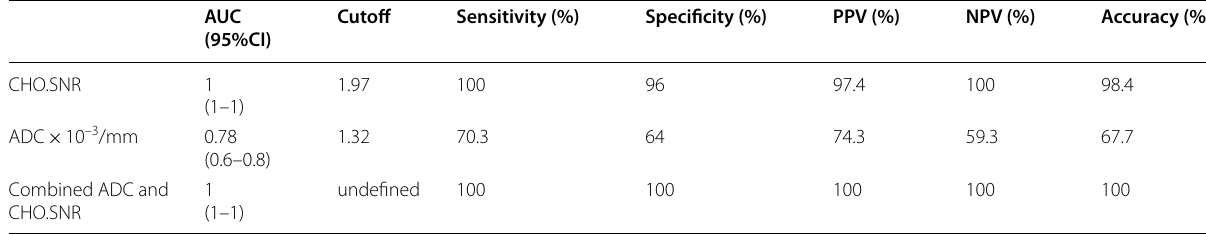
Table 3 Validity of CHO.SNR and ADC in differentiating fibroadenoma from mucinous tumors